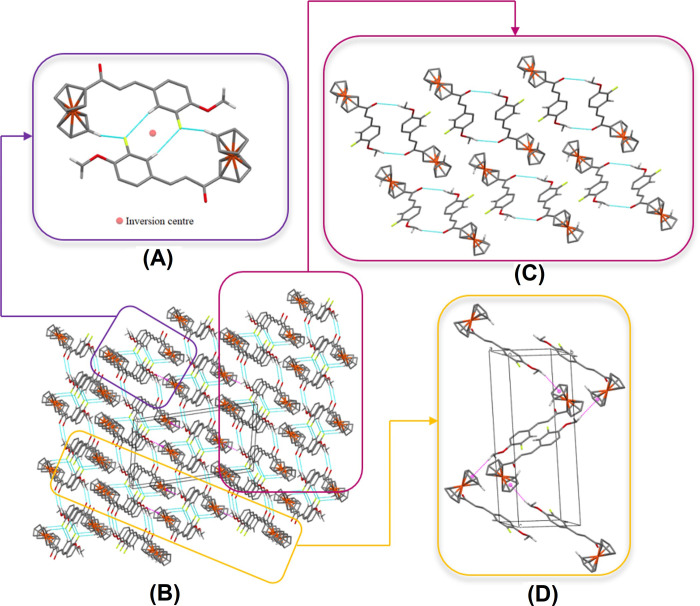
Crystal packing of Fc2.(A) A view of a centrosymmetric dimer with weak intermolecular C19—H19A⋯F1 and C4—H4A⋯F1 interactions shown as blue dotted lines (B) A full view of crystal packing within a unit cell (C) A partial parts of C20—H20C⋯O1 interactions (D) The head-to-tail arrangement of C20—H20A⋯Cg1.